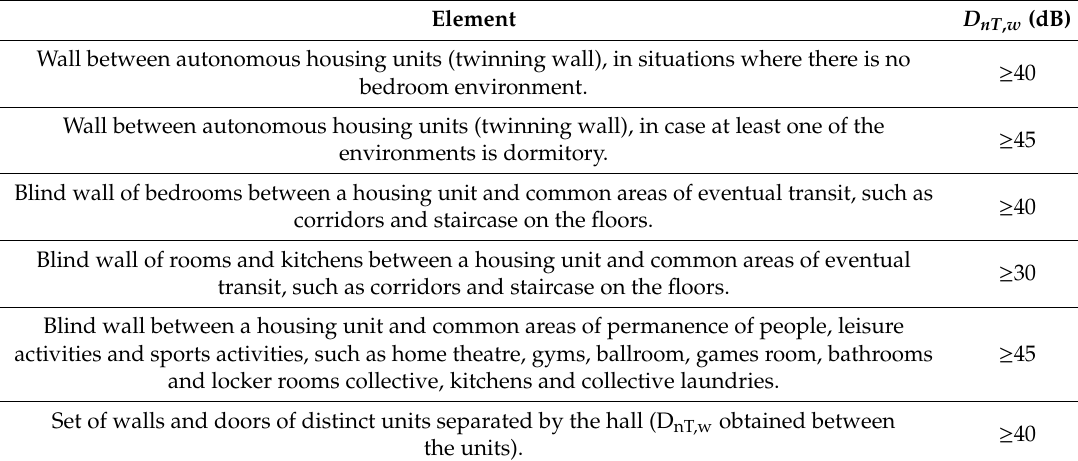
Table 3. Minimum values of the weighted standardized level di ff erence, D nT , w , between environments [15]. Element D nT , w (dB)